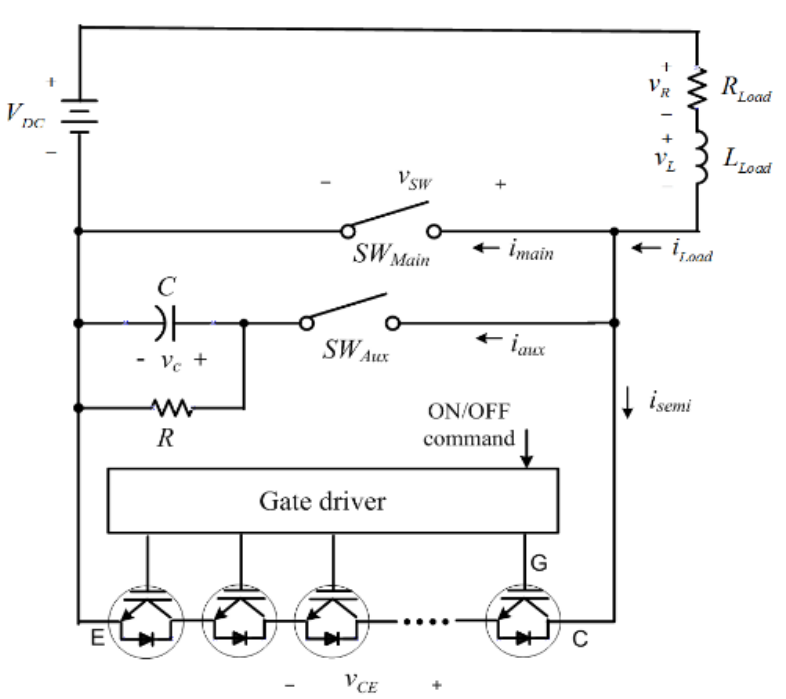
Figure 1. Concept of the proposed medium voltage DC (MVDC) hybrid circuit breaker.